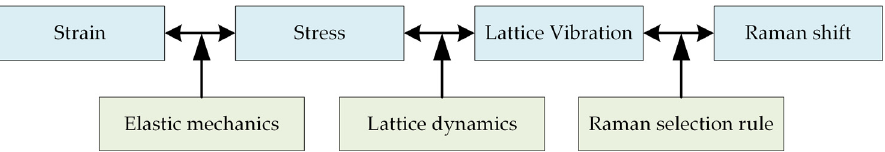
Figure 4. Raman spectrum of the (0001) plane GaN.